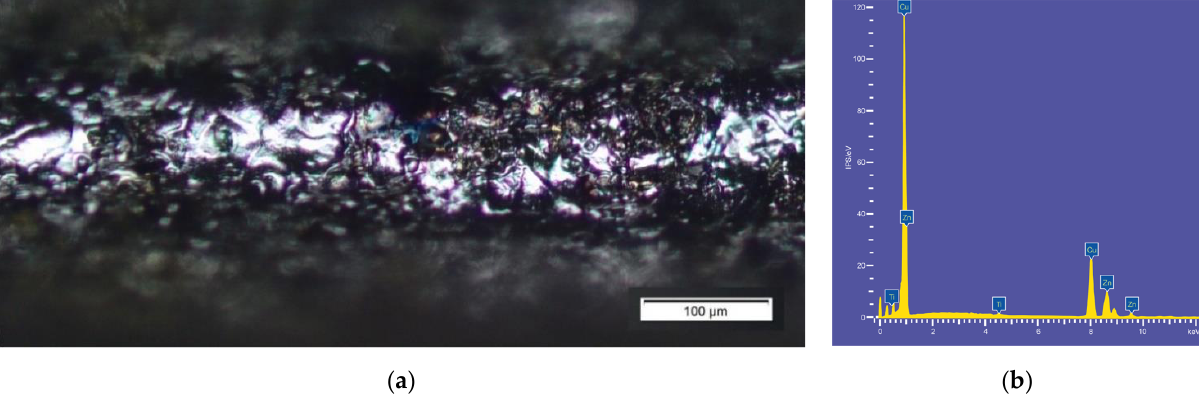
Figure 9. The surface being machined at the moment of wire breakage: ( a ) a photo of the surface at the moment of wire breakage; ( b ) elemental quantitative EDX analysis of the wire melting and breakage zone.